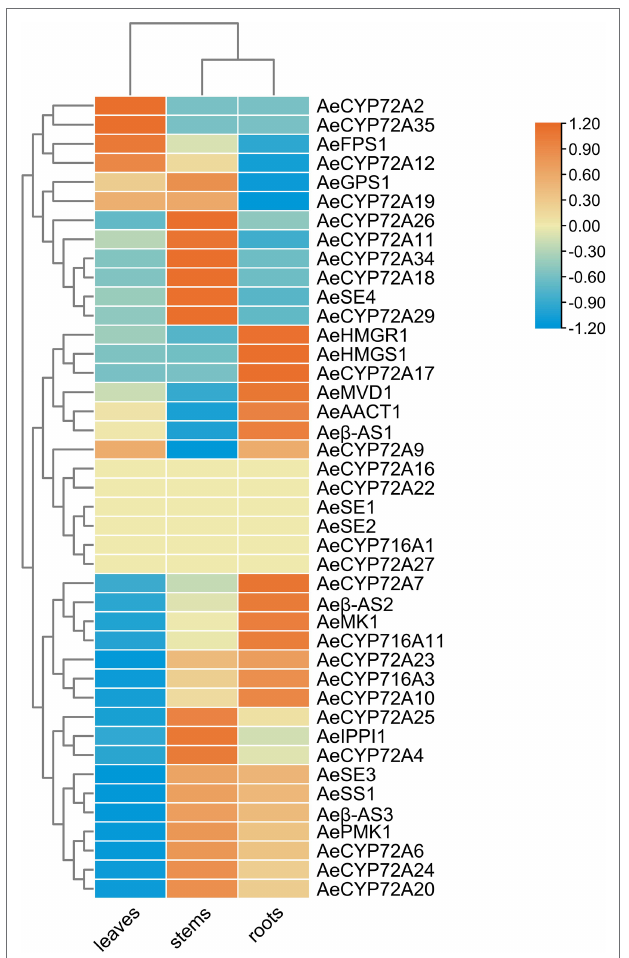
FIGURE 5 | Heatmap of gene transcript abundance in the saponin biosynthetic pathway of key enzyme genes at three different parts in Aralia elata . RPKM values are log2-based. Yellow and blue indicate high and low expression levels, respectively.